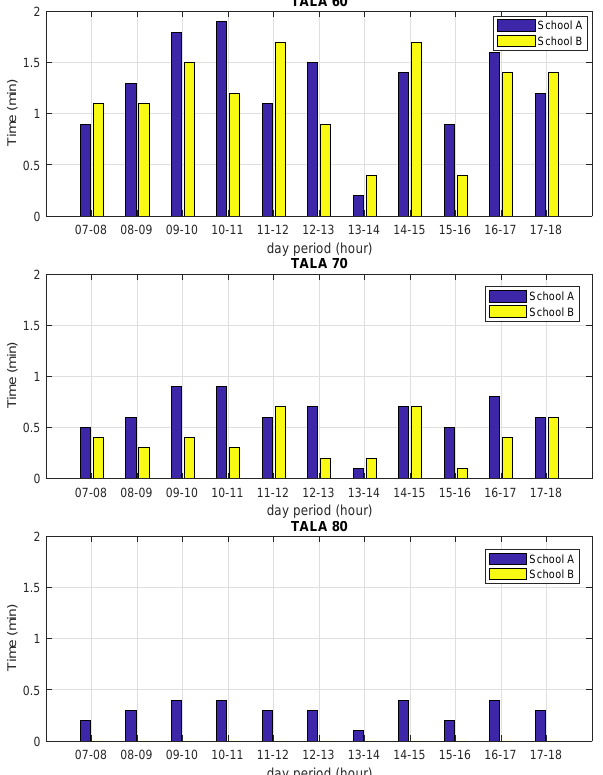
Figure 7: Comparison of TA60, 70 and 80, in minutes, for schools A and B.